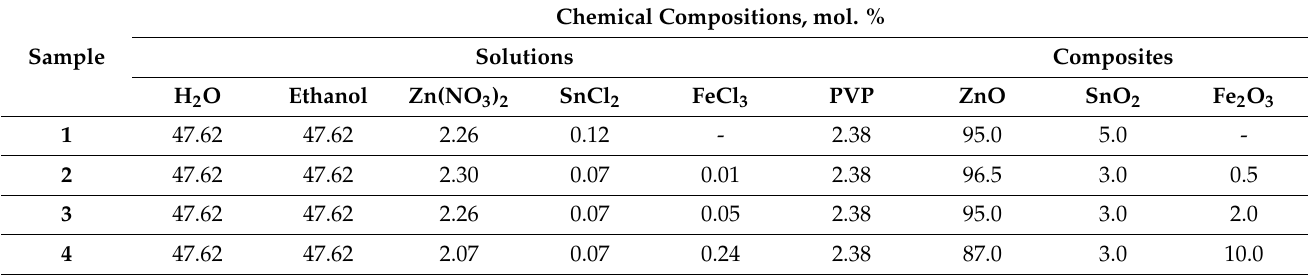
Table 1. Chemical compositions of prepared solutions and oxide composites. Chemical Compositions, mol. Sample